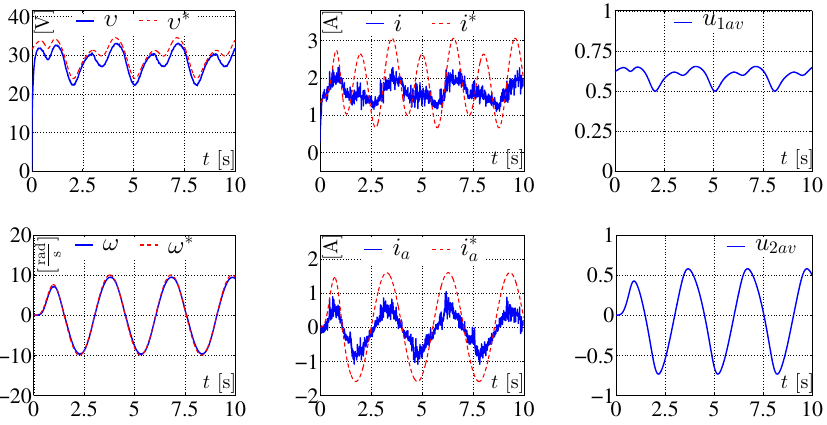
Figure 13. System response for Equations (40) and